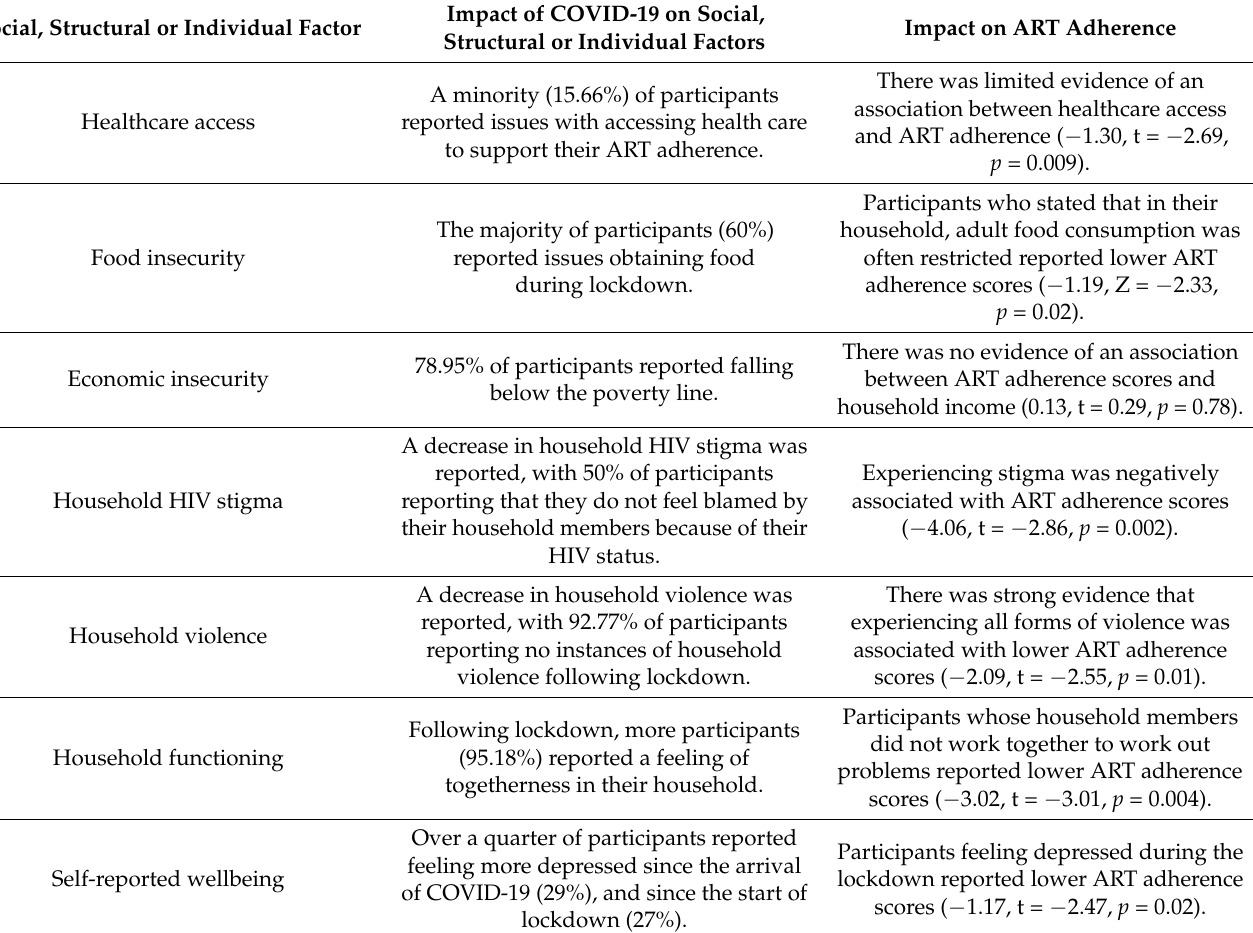
Table 5. Social factors impacting ART